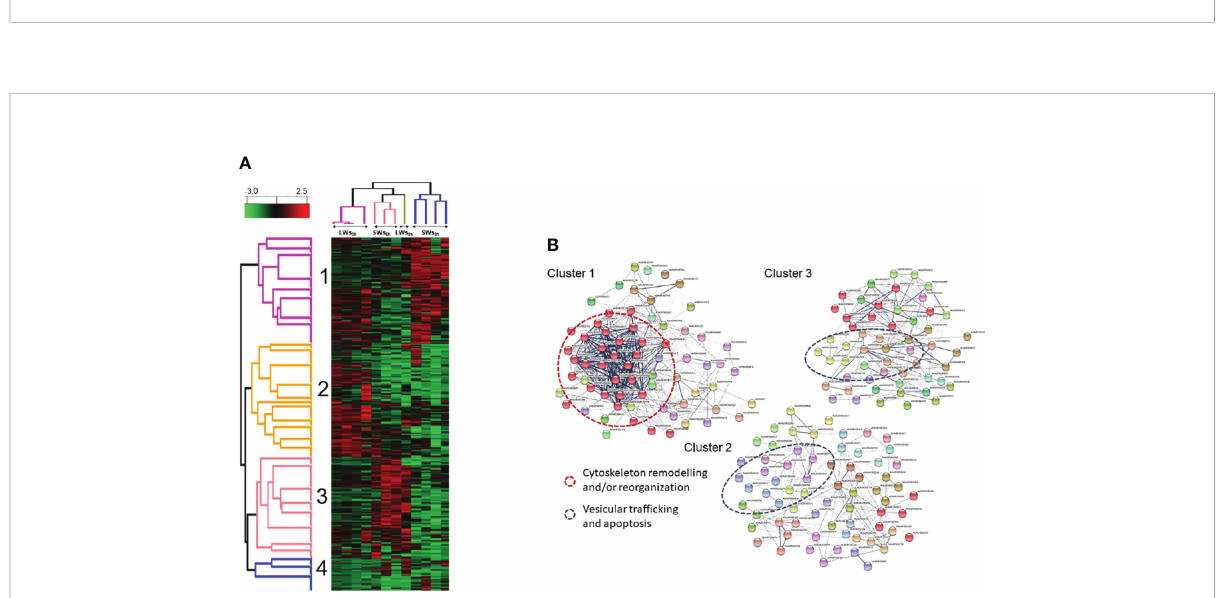
FIGURE 5 (A) Hierarchical k-means clustering of E/S proteins based on their normalized LFQ abundances. Parameters used: Distance metric, L1; Linkage rule, average; Constraint, none. LWs 3h = large-size tapeworms at three-hour time point, LWs 8h = large-size tapeworms at eight-hour time point, SWs 3h = small-size tapeworms at three-hour time point, SWs 8h = small-size tapeworms at eight-hour time point (Table S4). (B) An additional STRING PPI analysis with MCL clustering indicates enriched protein-protein interactions and biological functions (Table